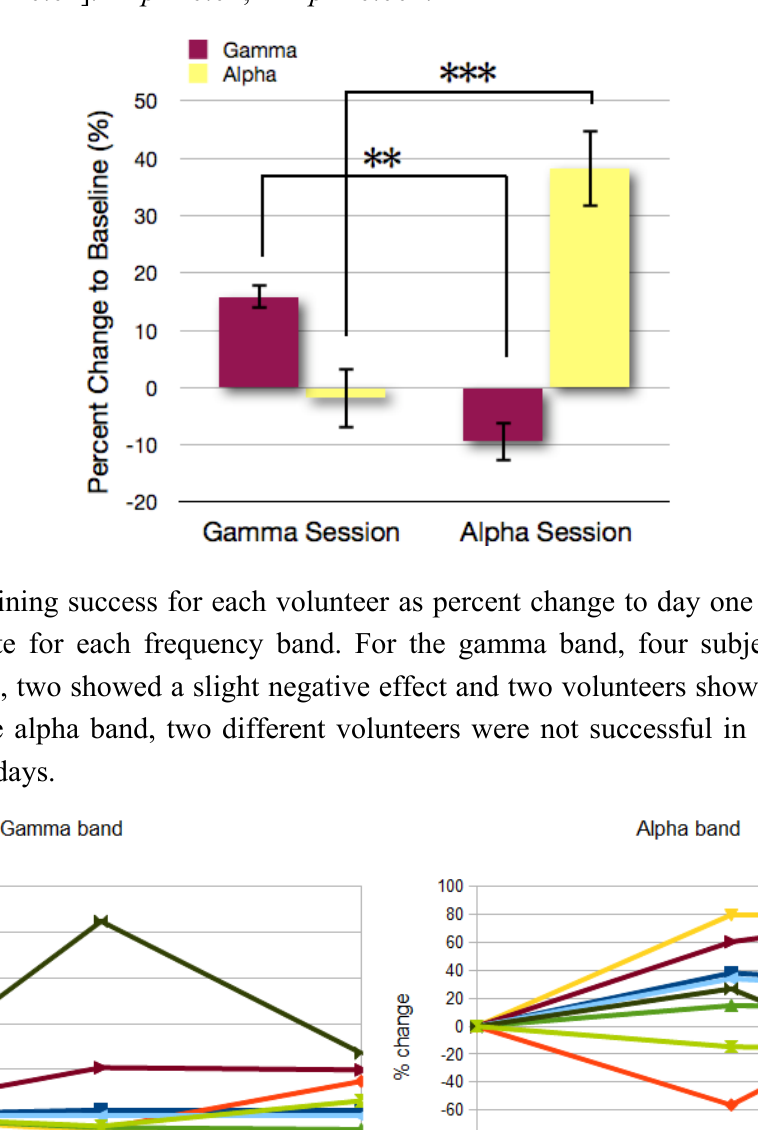
Figure 3. Percent change of gamma- and alpha-band activity in the gamma and alpha sessions within the last training day. Statistical tests revealed a higher increase of alpha power in the alpha sessions than in the gamma sessions [ t (7) = 5.47, p < 0.001] and a higher increase of gamma power in the gamma sessions than in the alpha sessions